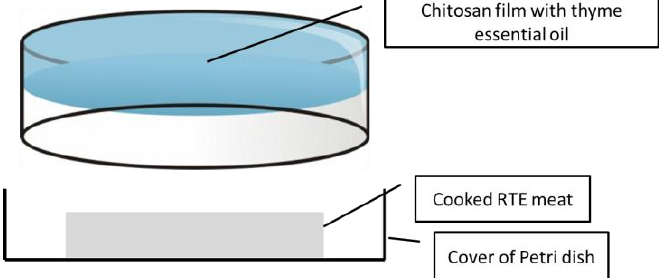
Figure 1 . Active packaging design. Figure 1. Active packaging design.